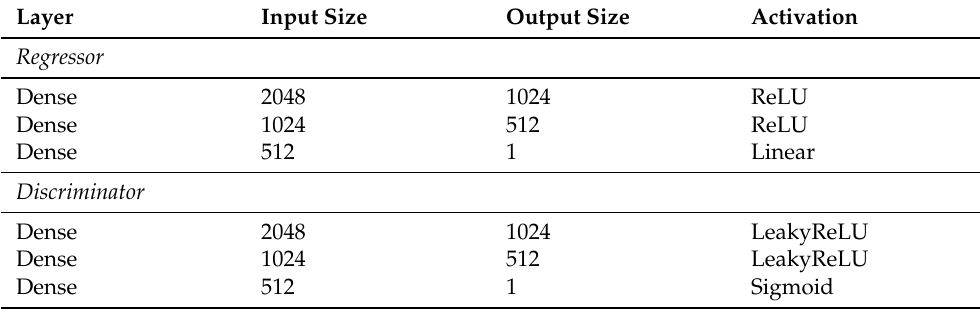
Table 1. Architectures details of the Regressor and Discriminator. We set α = 0.01 for the